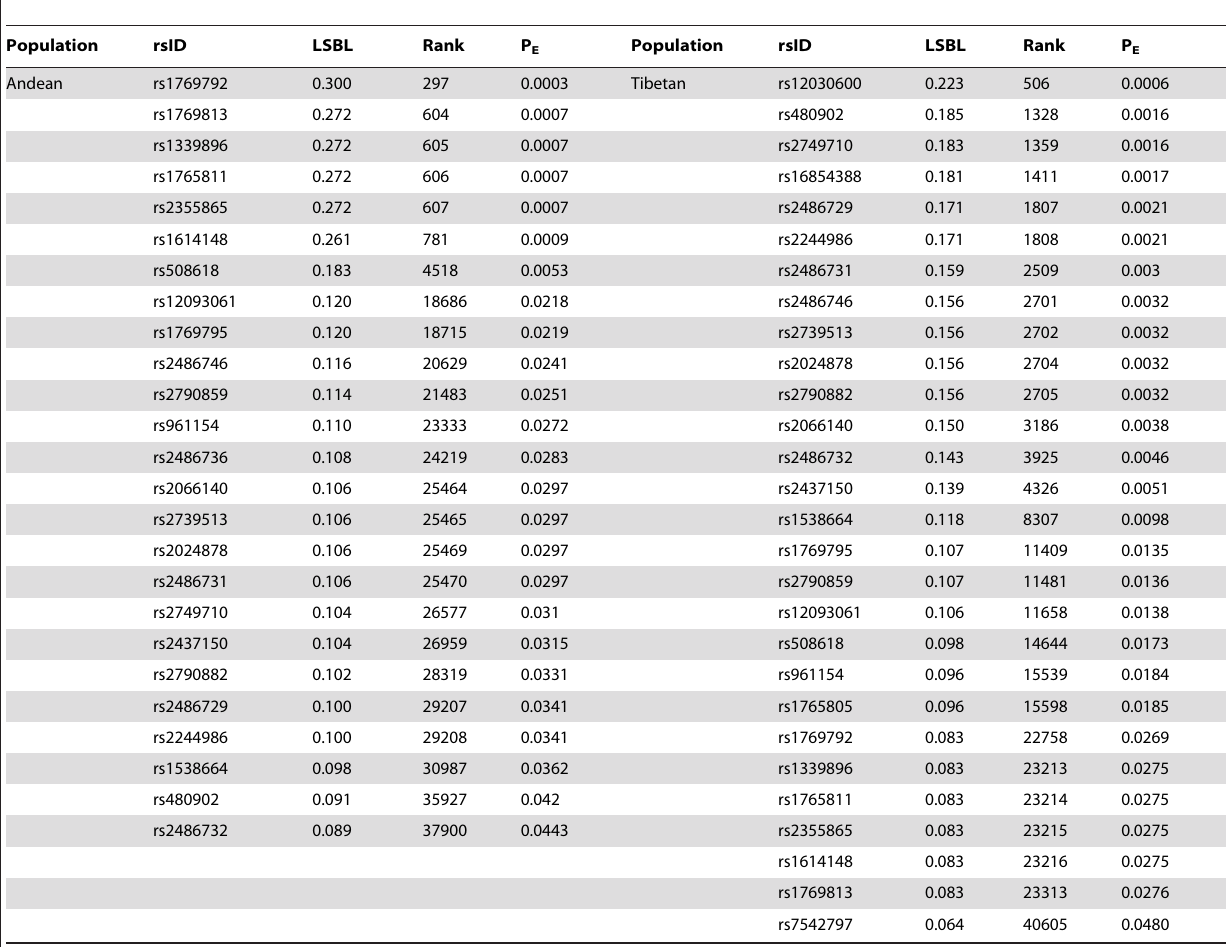
Table 3. Empirical distribution rank and P E value for each significant EGLN1 SNP in both Andeans and Tibetans.